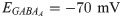
Determination of a pair of effective conductances in experiment.a, schematic diagram of the recording configuration when a pyramidal neuron receives a pair of E and I inputs. A voltage clamp is made at the soma and a dynamic clamp is made on the dendritic trunk about 100 μm away from the soma. Somatic voltage is clamped from −90 mV to −50 mV when both E and I inputs are given simultaneously by the dynamic clamp on the dendrite. b, I-V relations obtained after applying the voltage clamp with the I reversal potentials EGABAA=-70mV (green) and EGABAA=-80mV (orange), respectively. The data are collected at the time 10 ms after the onset of the stimulus. The voltage value shown in the abscissa is relative to the resting potential. c, a pair of E (red) and I (blue) conductances determined by SIM (open circle) and IM (solid circle). Solid curves are the reference conductances measured by given an individual E or I input separately. Dash curves are the local E and I conductances on the dendritic trunk 100 μm away from the soma. The local E conductance takes the form proportional to e−t/5 − e−t/7.8 (time unit: ms) with a peak amplitude of 2.5 nS, and the local I conductance takes the form proportional to e−t/6 − e−t/18 (time unit: ms) with a peak amplitude of 4 nS. d, the peak-amplitude relative error of the E and I conductances determined by IM and SIM across 7 neurons. The thick blue bar indicates the mean value of the peak amplitude error and the thin red bar indicates the range of the error.